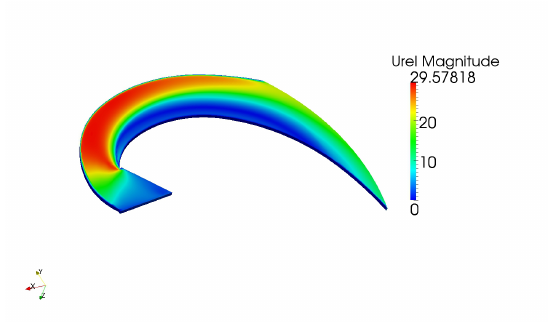
Figure 3: Half of the channel showing steady state velocity